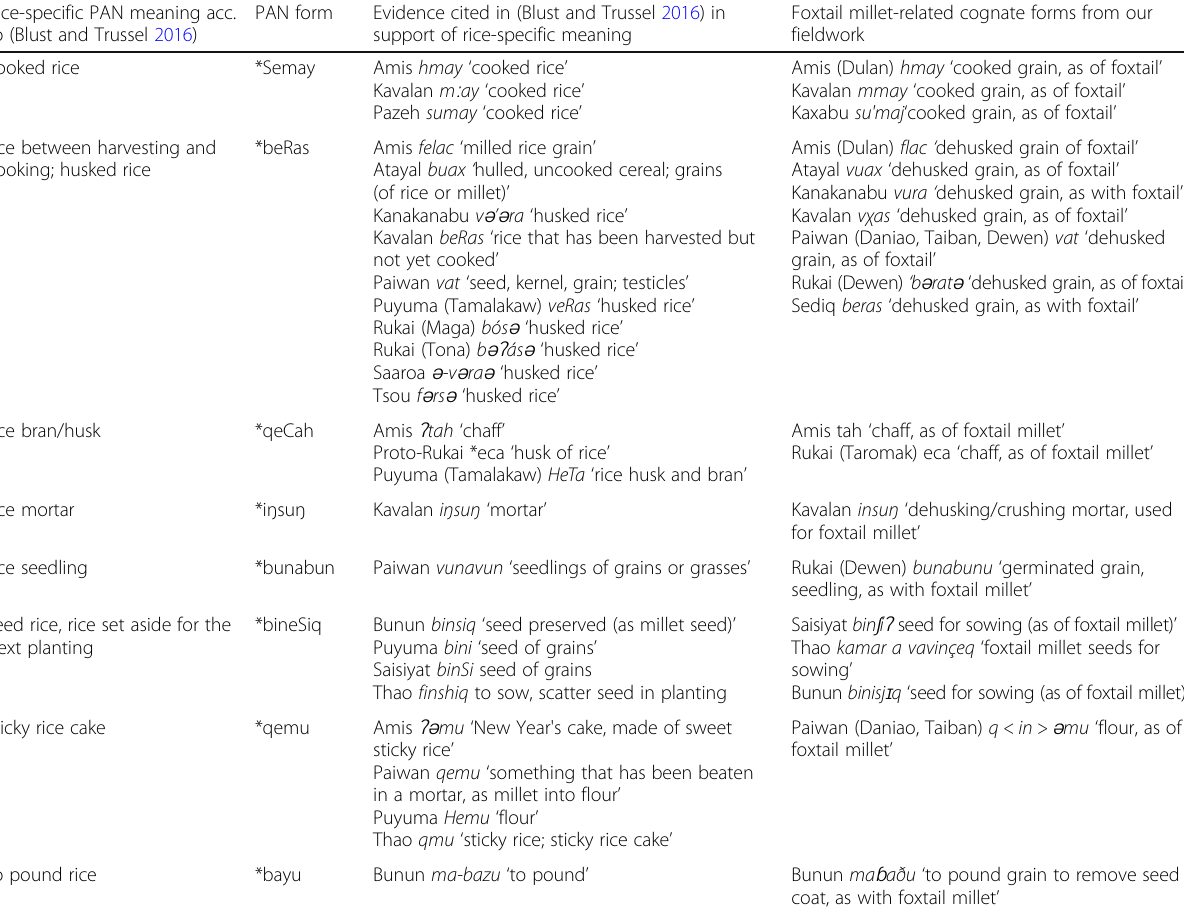
Table 2 Formosan language evidence for the meaning of eight reconstructed agricultural words Rice-specific PAN meaning acc. to (Blust and Trussel